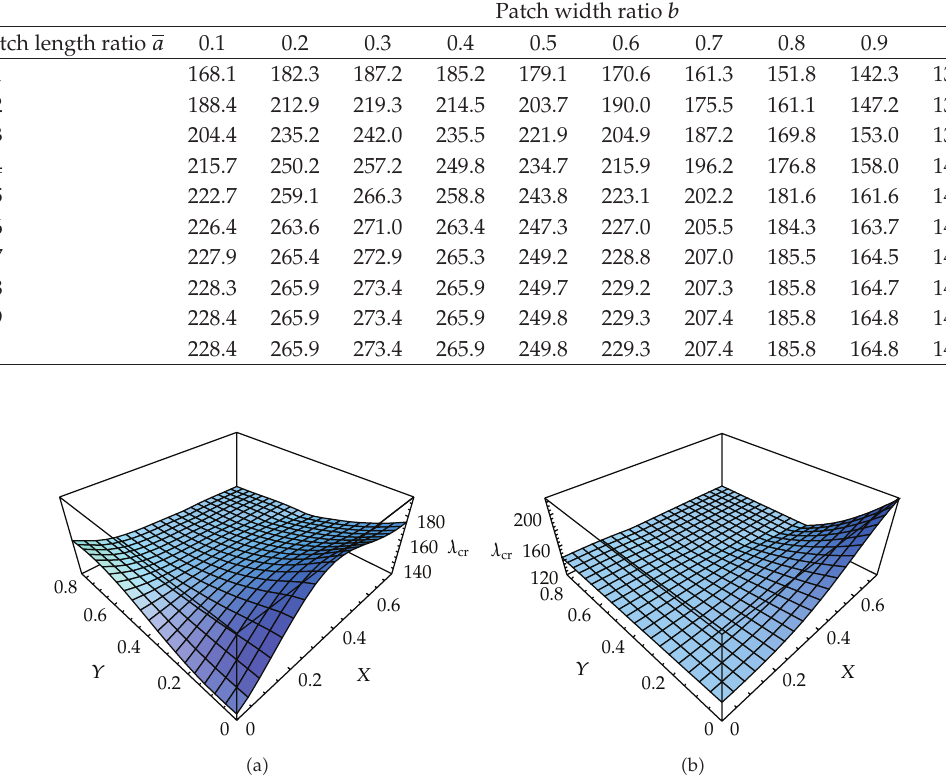
Figure 2: Variations of critical dynamic pressure versus patch location: (cid:3) a (cid:6) with an aluminum patch and (cid:3) b (cid:6) with a PZT5H